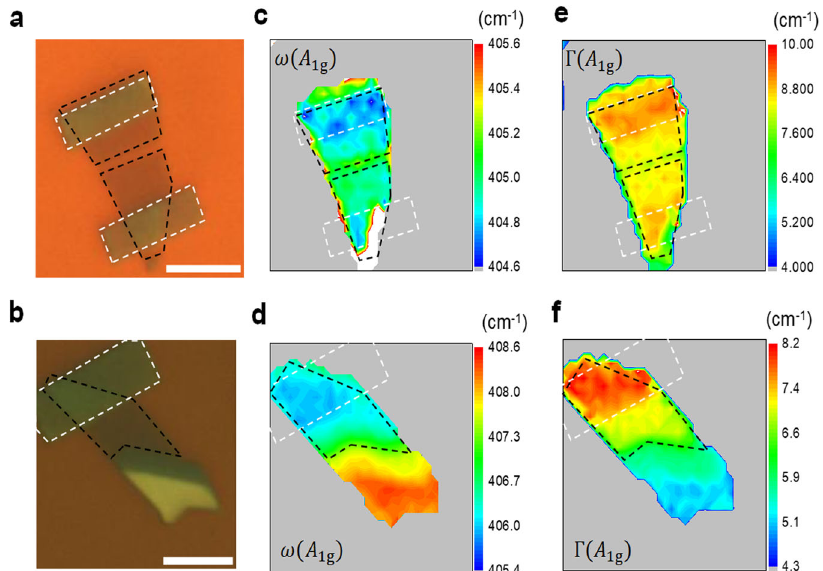
Fig. 2 Raman spectroscopy for In/MoS 2 . a , b Optical images of 1L- and 2L-MoS 2 (dashed black-boxed region) on SiO 2 substrates, respectively. White boxed regions: 5-nm-thick In-deposited regions. Scale bar: 5 μ m. c , d A 1g energy ( ω ) maps for 1L- and 2L-MoS 2 , respectively. e , f Full- width at half-maximum ( Γ ) maps of A 1g for 1L- and 2L-MoS 2 ,